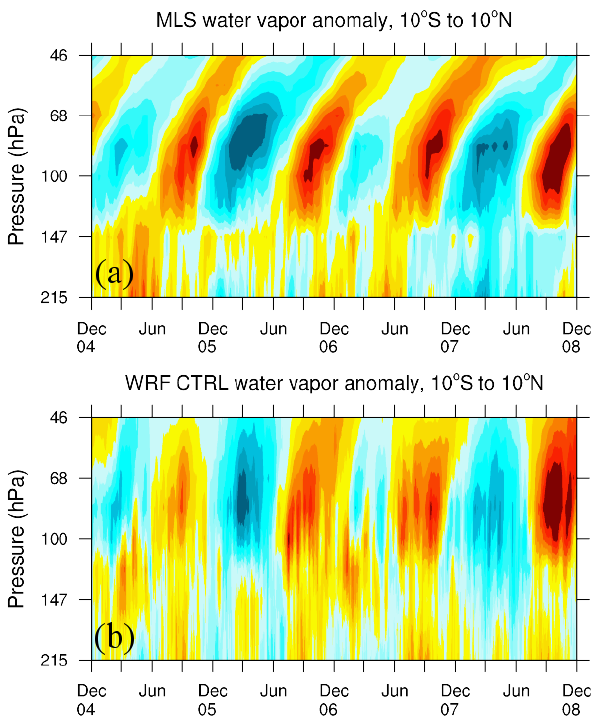
Fig. 1. Height-time cross section of inner tropical (10 ◦ S-10 ◦ N) mean water vapor anomalies from (a) MLS and (b) the WRF CTRL run. The anomalies are relative to inner tropical mean averaged from 1 December 2004 to 30 November 2008. the inner tropics is 0.67 mm s − 1 at 100 hPa, somewhat larger than the observed mean vertical velocity about 0.4 mm s −